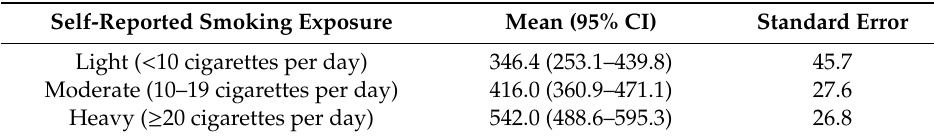
Table 2. The mean value and standard errors of the salivary cotinine levels recorded immediately according to self-reported smoking exposure ( n = 172).